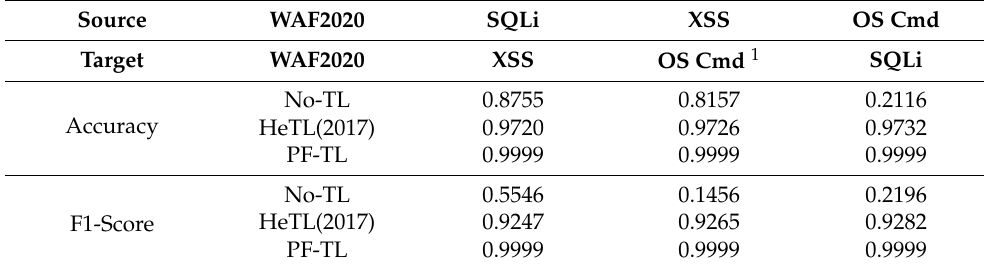
Table 10. Performance comparison of transfer learning on Scenario